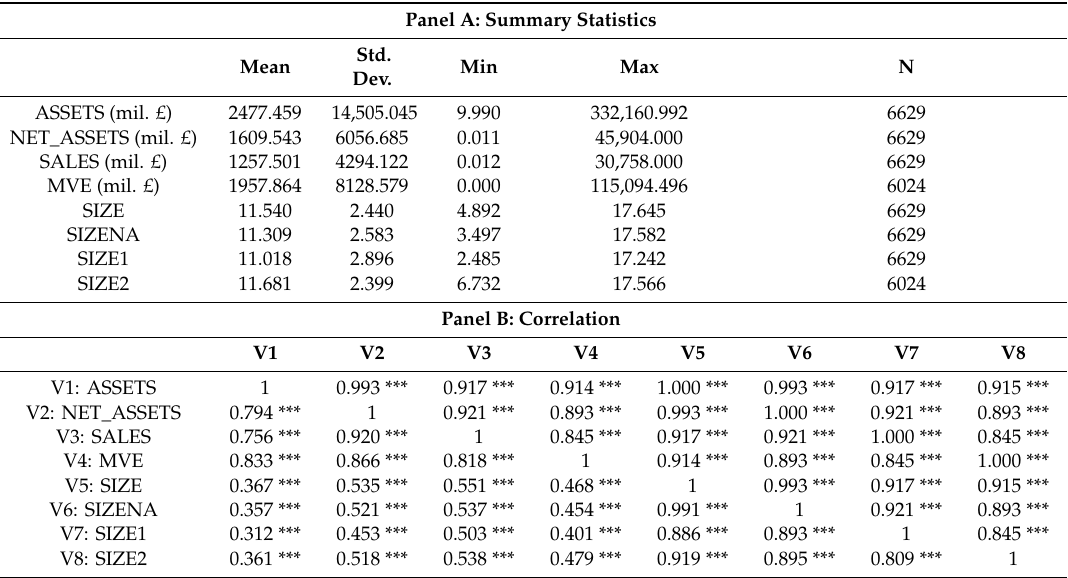
10.0010.5011.0011.5012.0012.50